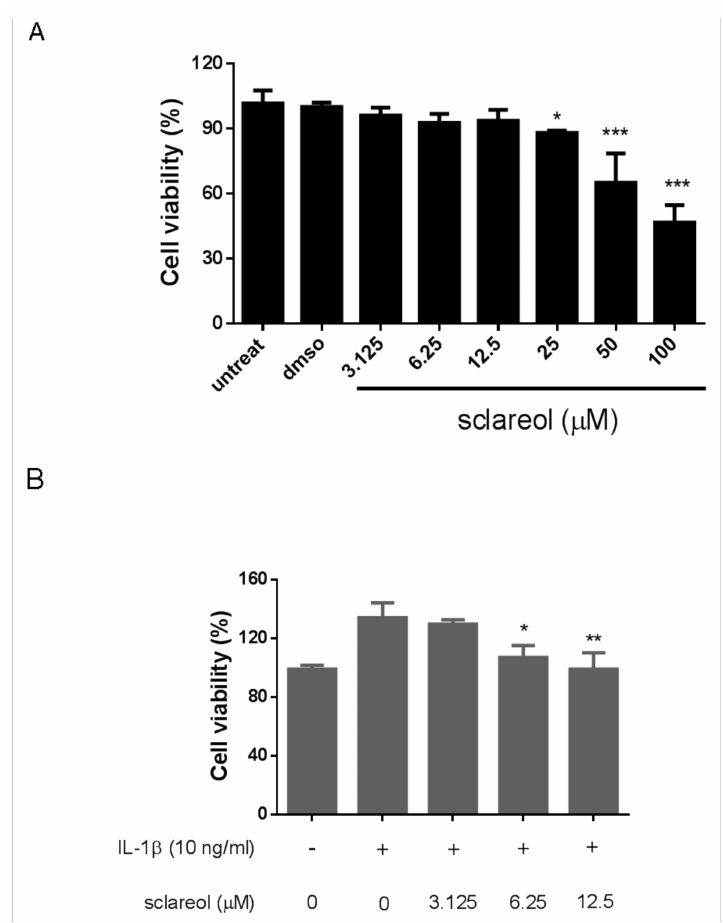
Figure 5. Effects of sclareol on SW982 cell viability. ( A ) The cytotoxicity of sclareol to SW982 cells was evaluated with the CCK-8 assay in the absence of IL-1 β . ( B ) The cell viability of SW982 cells treated with IL-1 β for 72 h was monitored. Each bar on the bar graph represents the mean ± SD of triplicate tests. The data are representative of three independent experiments with similar results. * p < 0.05, ** p < 0.01, and *** p < 0.001 versus vehicle treated dimethyl sulfoxide (DMSO)